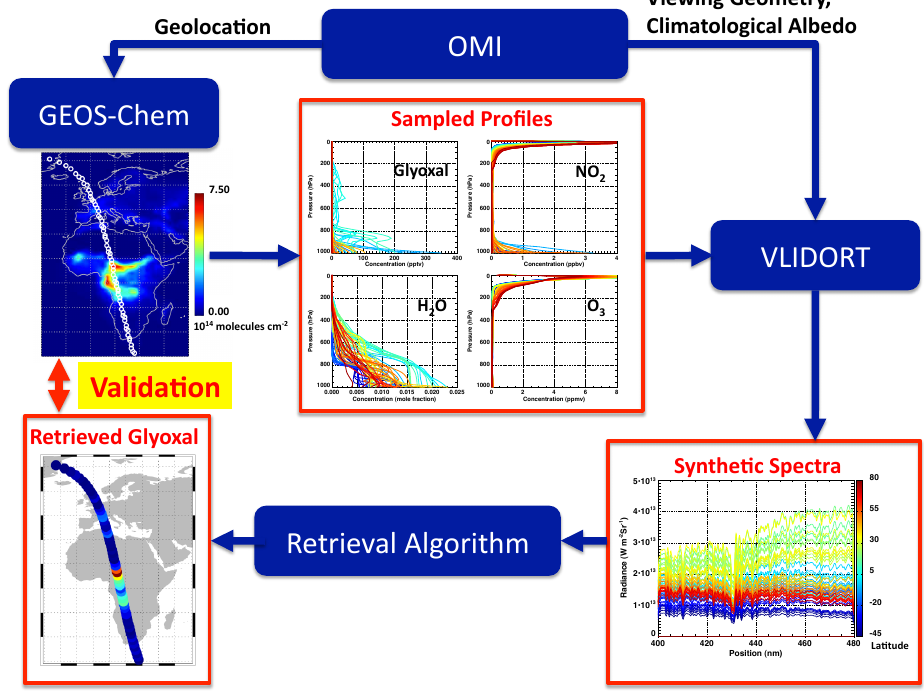
Figure 3. Schematic of the OSSE approach used to optimise the retrieval algorithm.